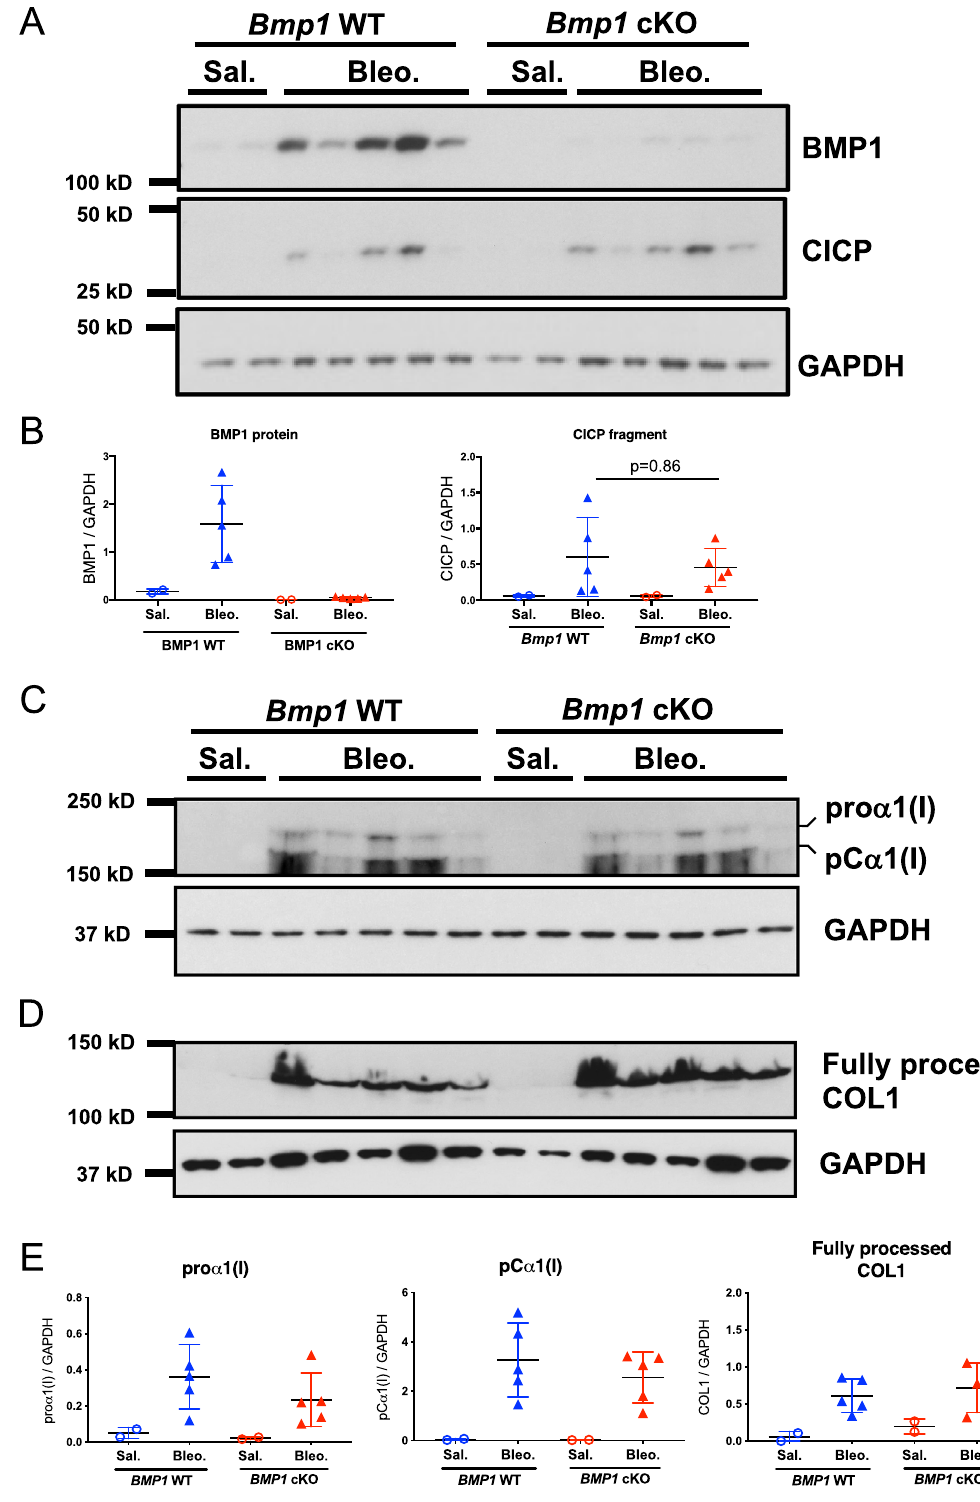
Figure 6. Bmp1 deletion does not reduce CICP production during bleomycin-induced lung fibrosis. ( A ) Equal amounts of total proteins were subject to western blot for the detection of BMP1 and CICP in lung tissues. GAPDH was used as a loading control. ( B ) Quantification of relative protein expression of BMP1 and CICP in lung tissues by normalizing with GAPDH. ( C , D ) Representative western blot of proα1(I), pCα1(I) and fully processed COL1 in lung lysates, each lane represents single biological sample. ( E ) Quantification of relative protein expression of proα1(I), pCα1(I) and fully processed COL1 normalized by GAPDH. Data represents mean ± SD. p-value is calculated using one-way